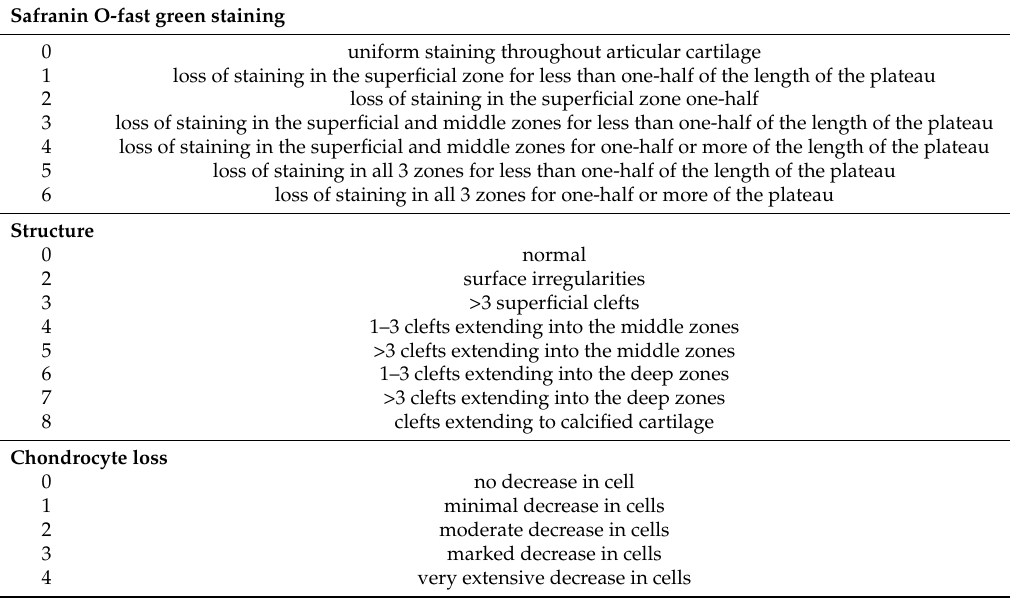
Table 3. Modified Mankin Score (criteria for histological